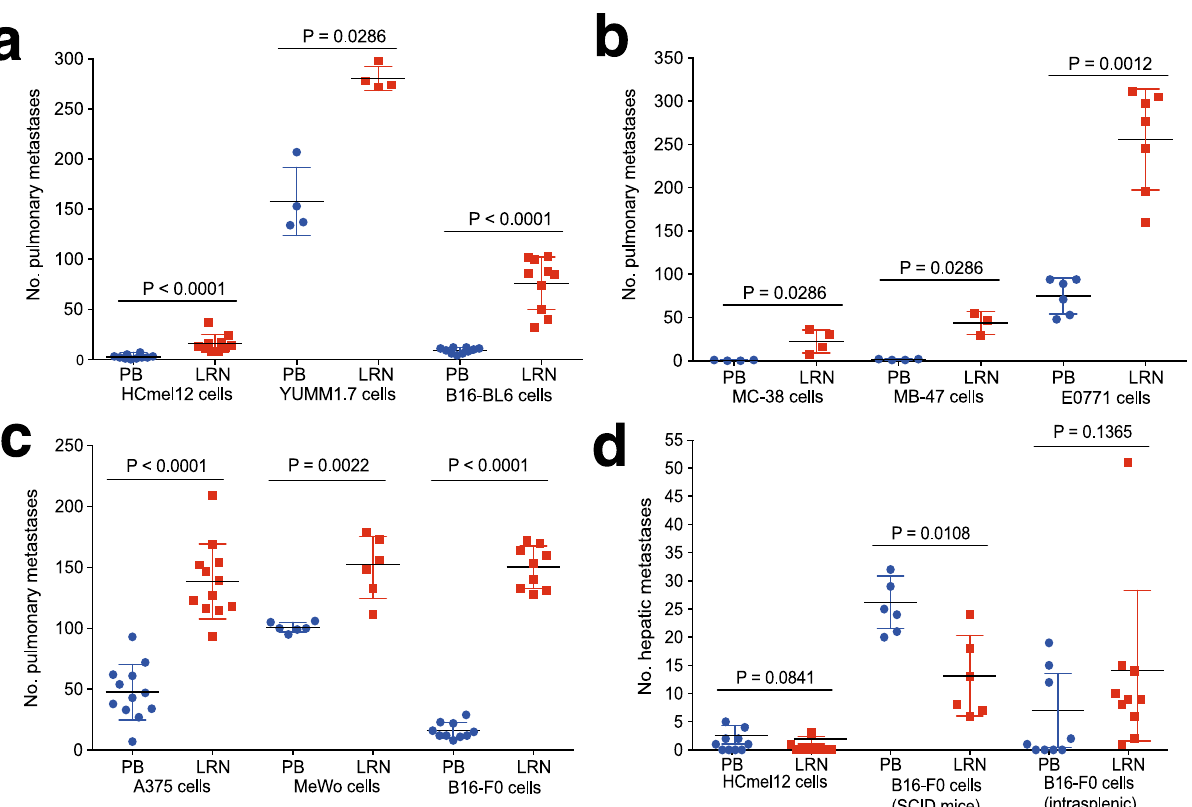
Fig. 2 The effect of LRRN4CL over-expression on metastatic colonisation. a The number of metastatic colonies in the lungs of mice 10 days after being tail vein dosed with melanoma cell lines (5 × 10 5 HCmel12 cells, 4 × 10 5 YUMM1.7 cells and 0.25 × 10 5 B16-BL6 cells) that have been stably